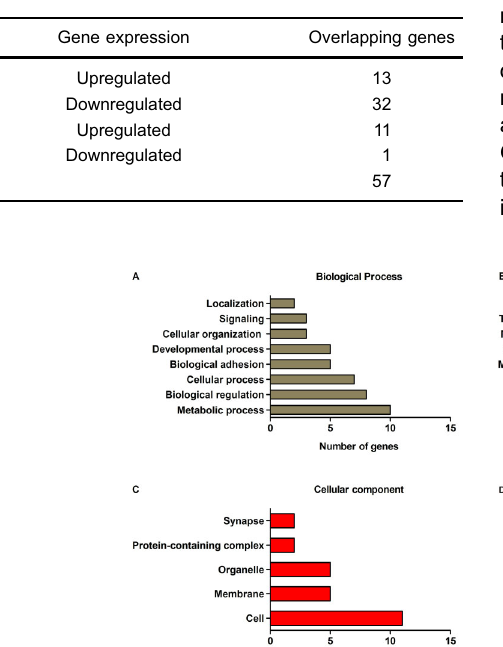
Table 5. Overlapping genes identi fi ed after integration of copy number alteration (CNAs) and gene expression data of AHOL1 cell